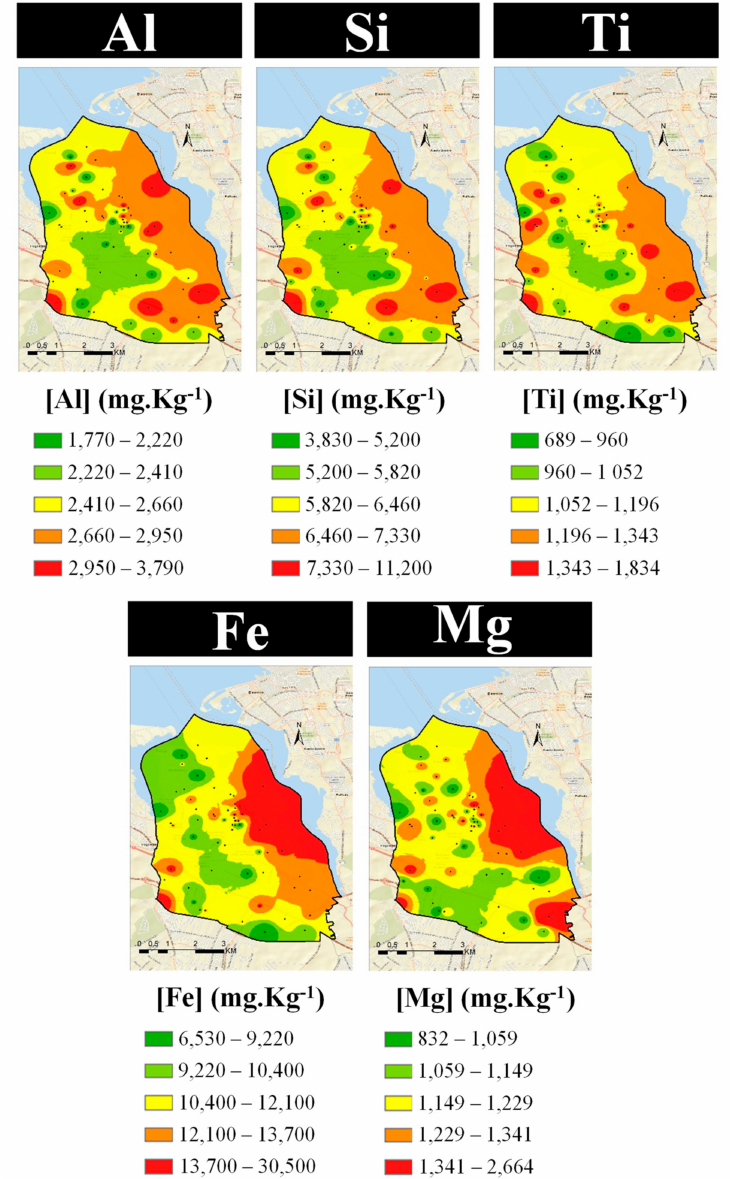
Figure 10. Spatial distribution of soil-related elements in the study area: ( top ) natural origin and ( bottom ) a mixture of natural and anthropogenic